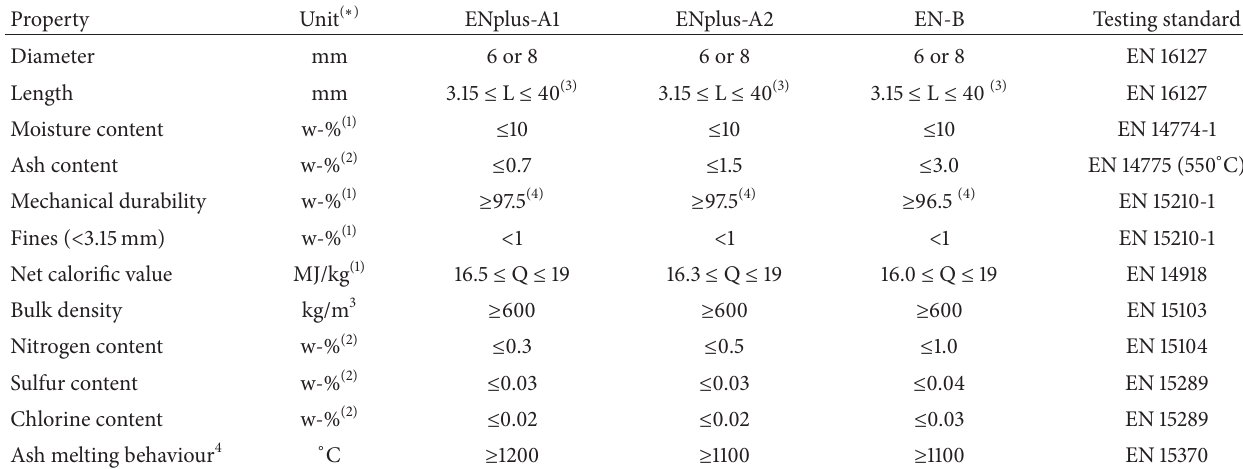
Table 1: Ranges of EN 14961-2 values for the most crucial wood pellet